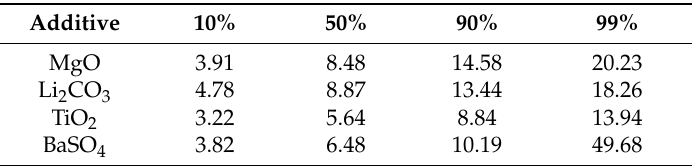
Figure 2. Backscattered electron images of sections of the primer prior to exposure to NSS. The mounting medium is at the top of the image, the primer is in the centre, and the AA2024 ‐ T3 is at the bottom of all images. Table 2. Inorganic additive size distribution presented as the percentage of particles at a particular size in